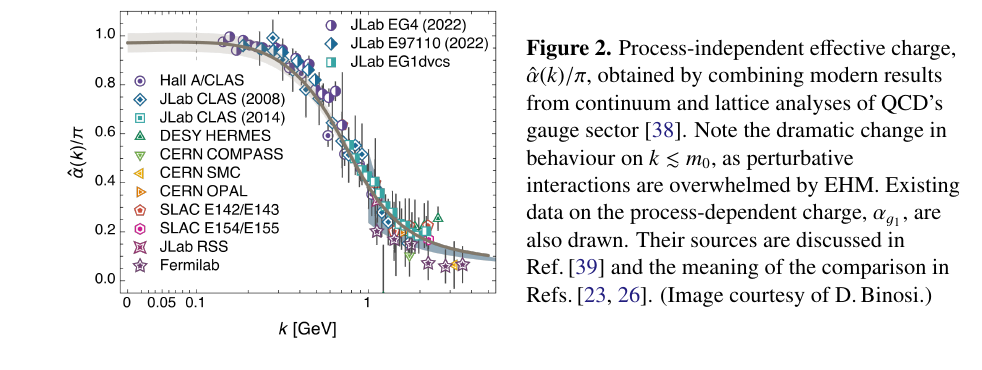
Figure 2. Process-independent e ff ective charge, ˆ α ( k ) /π , obtained by combining modern results from continuum and lattice analyses of QCD’s gauge sector [38]. Note the dramatic change in behaviour on k ≲ m 0 , as perturbative interactions are overwhelmed by EHM. Existing data on the process-dependent charge, α g also drawn. Their sources are discussed in Ref.[39] and the meaning of the comparison in Refs.[23, 26]. (Image courtesy of